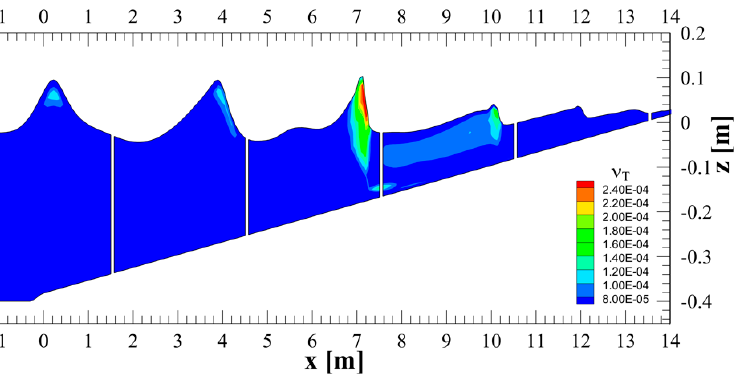
Figure 5. Test 3. Cnoidal wave. Instantaneous free-surface elevation and contour of the eddy viscosity obtained using the proposed WTENO model.